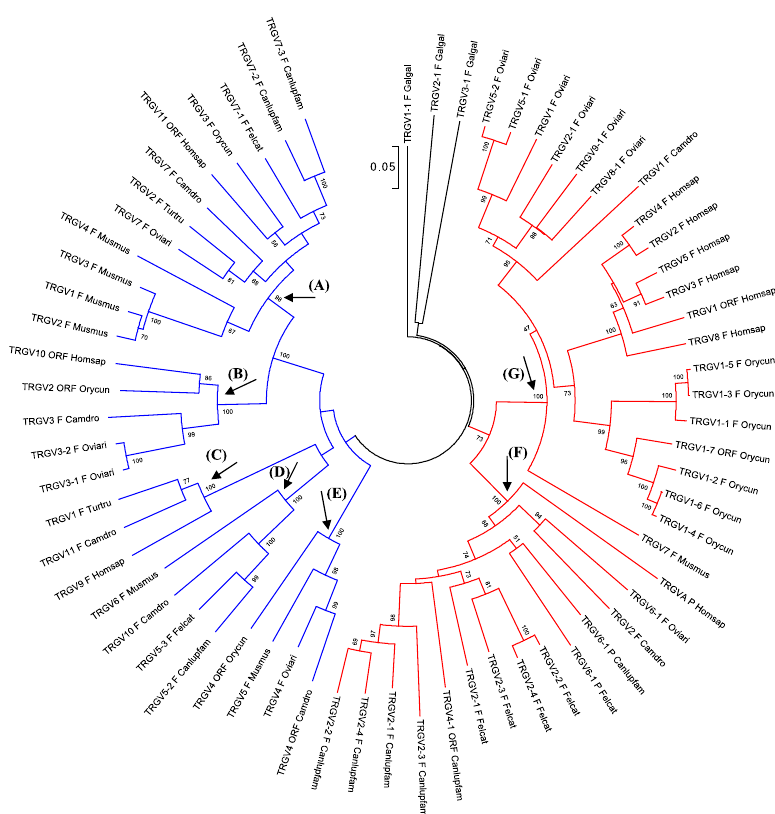
Figure 3. Evolutionary relationships of the eutherian mammalian TRGV genes. The TRGV as well as the TRGJ (Figure 4) and TRGC (Figure 5) gene sequences used for the phylogenetic analysis were retrieved from the IMGT ® database (IMGT Repertoire, http: // www.imgt.org) if annotated, or from the GenBank database using the accession numbers reported in the reference articles listed in Tables 2 and 4. Chicken (Galgal) TRG genes were used as the outgroup [66]. For simplicity, we included in the analysis the TRGV genes belonging to a single species for each mammalian suborder in which the genomic organization of the TRG locus has been inferred. One member gene for each of the chicken (Galgal) TRGV subgroups was used as an outgroup. Multiple alignments of the V-region nucleotide sequences of functional genes and in-frame pseudogenes were carried out with the MUSCLE program [111]. The evolutionary analyses were conducted in MEGA7 [112]. We used the neighbor-joining (NJ) method to reconstruct the phylogenetic tree [113]. The percentage of replicate trees in which the associated taxa clustered together in the bootstrap test (100 replicates) is shown next to the branches [114]. The trees are drawn to scale, with branch lengths in the same units as those of the evolutionary distances used to infer the phylogenetic trees. The evolutionary distances were computed using the p-distance method [115], and the units are the number of base di ff erences per site. The analysis involved 66 nucleotide sequences. All positions containing gaps and missing data were eliminated. There were a total of 176 positions in the final dataset. Monophyletic groupings described in the text are indicated by capital letters. The blue and red branches of the tree highlight two major groupings of the mammalian genes. The IMGT six-letter standardized abbreviations for species (Homsap (human), Musmus (mouse), Felcat (cat), Oviari (sheep), Camdro (dromedary), Turtru (dolphin), Orycun (rabbit)) and nine-letter abbreviations for subspecies (Canlupfam, dog) taxa are